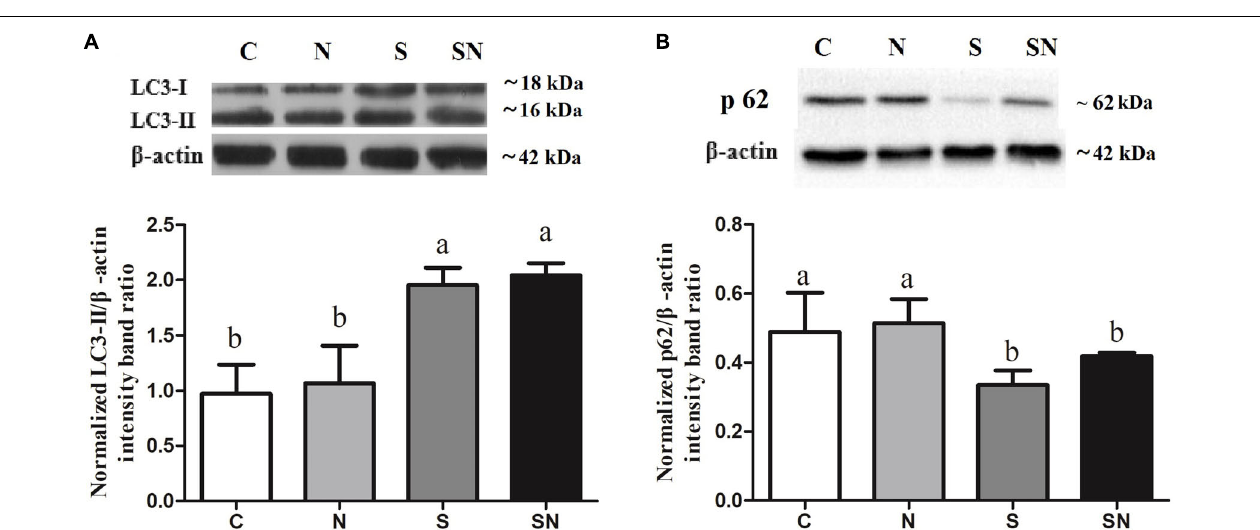
FIGURE 5 | Effect of Fe 3 O 4 -NPs on GSH-Px (A) , CAT (B) , SOD (C) , and MDA (D) enzyme activities in the livers of chickens exposed to Fe 3 O 4 -NPs in the absence or presence of S. Enteritidis administration. Values represent the mean ± SEM. Different letters indicate statistically significant differences.